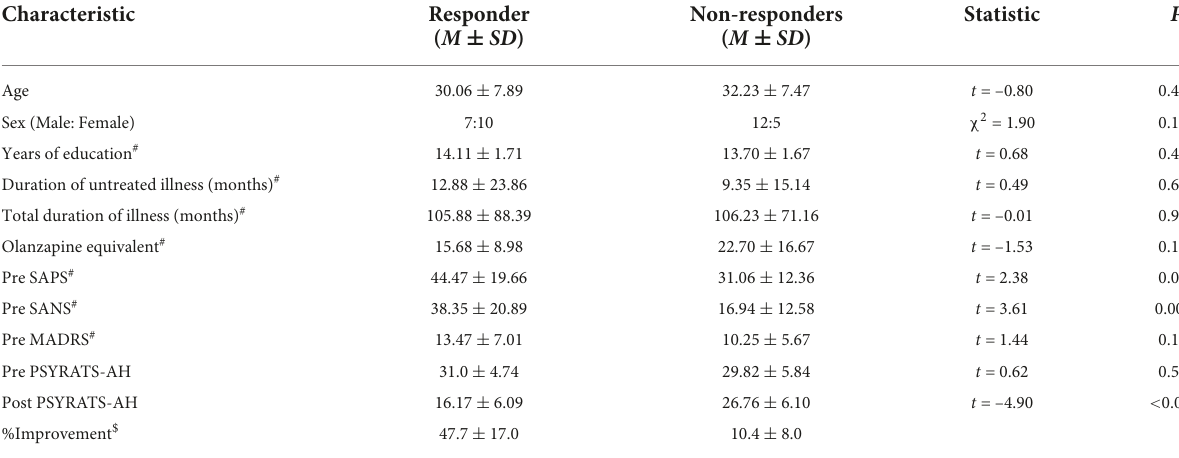
TABLE 1 Demographic table for responders ( n = 17) and non-responders ( n = 17).